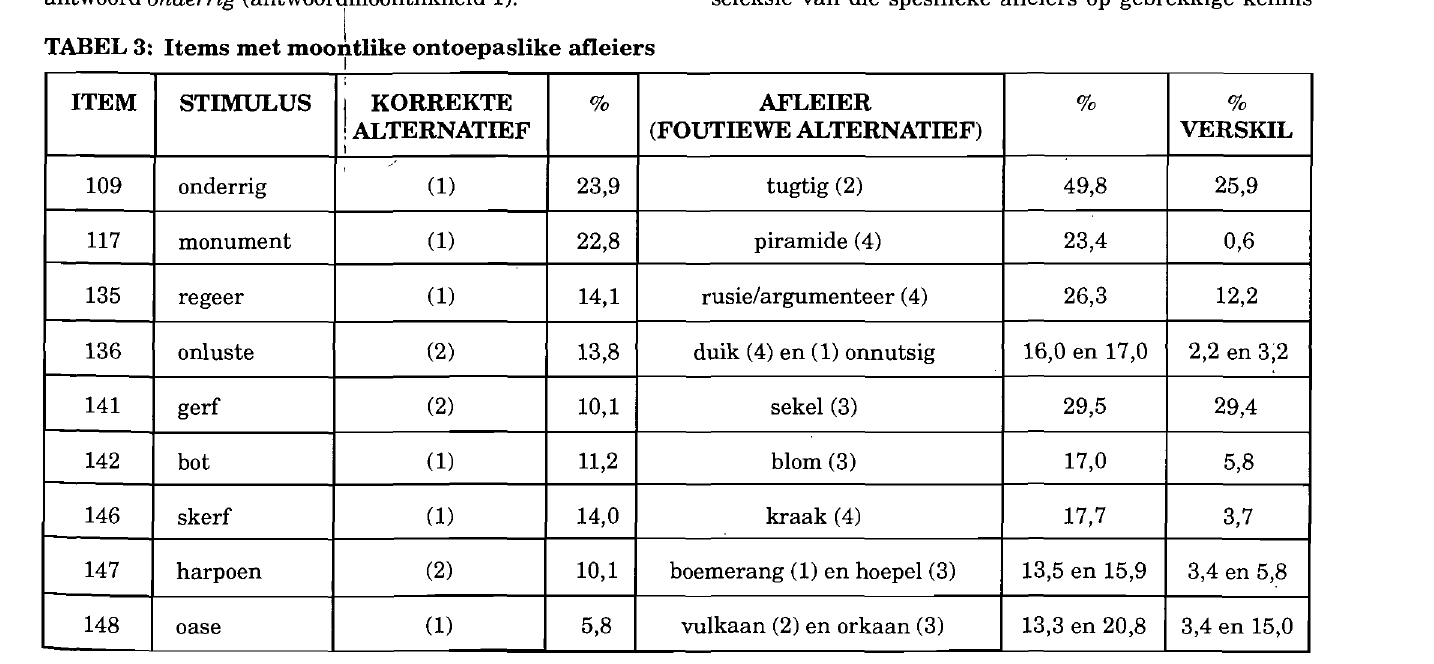
TABEL 3: Items met mooltlike ontoepaslike afleiers